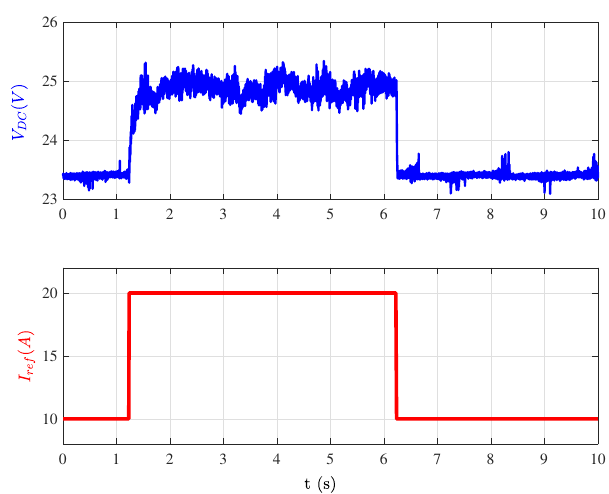
Figure 7. Influence of the reference current on the DC bus voltage. The other parameters are set to: ψ = 180 ◦ , θ p = 150 ◦ , R L = 15 Ω , and ω = 800 rpm.